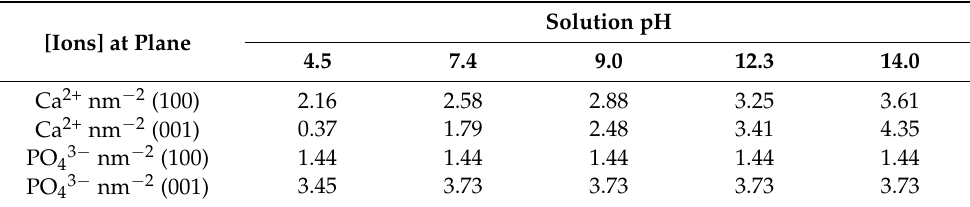
Table 2. pH-dependent amount of Ca 2+ and PO 4 3- at various planes of HA [49]. [Ions] at Plane